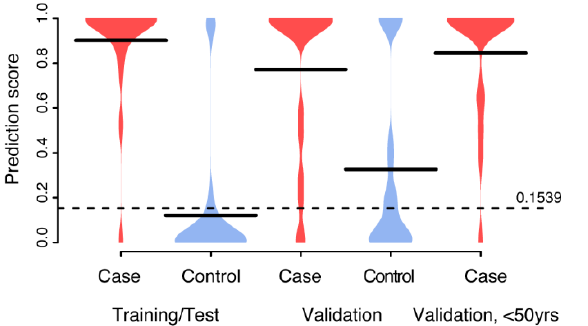
Figure 5. Distribution of prediction scores from the combined model. Prediction scores across the training/test, validation and the third replication data (Case 2 in Table 1) datasets. The dotted horizontal line corresponds to the cut-off (0.1539) defined during training. Thick black lines indicate mean values.